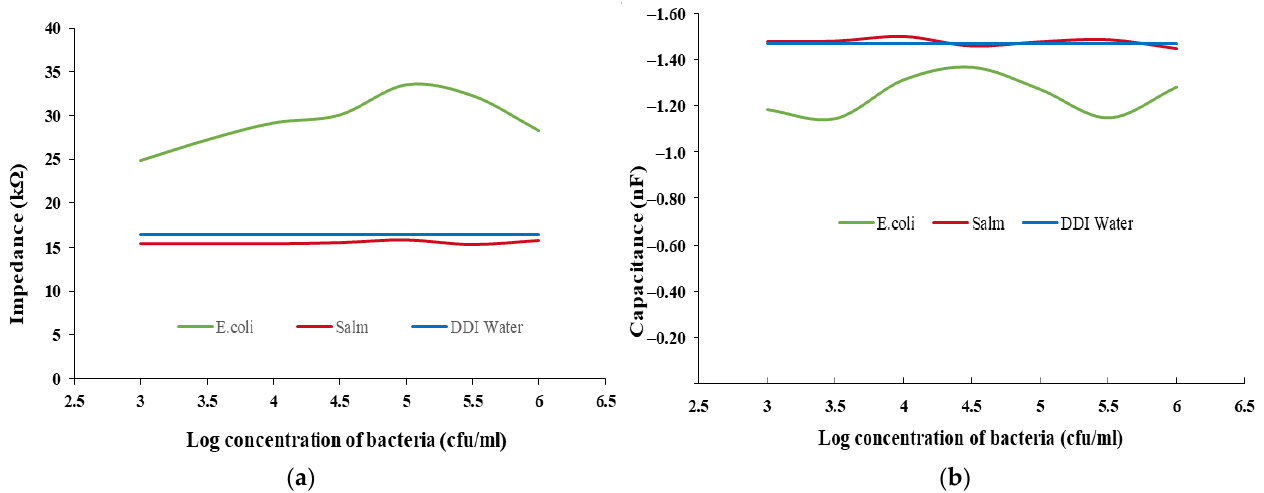
Figure 6. Differences in the ( a ) impedance and ( b ) capacitance between E. coli and Salmonella samples with NC at the characteristic frequency of 7.69 MHz.